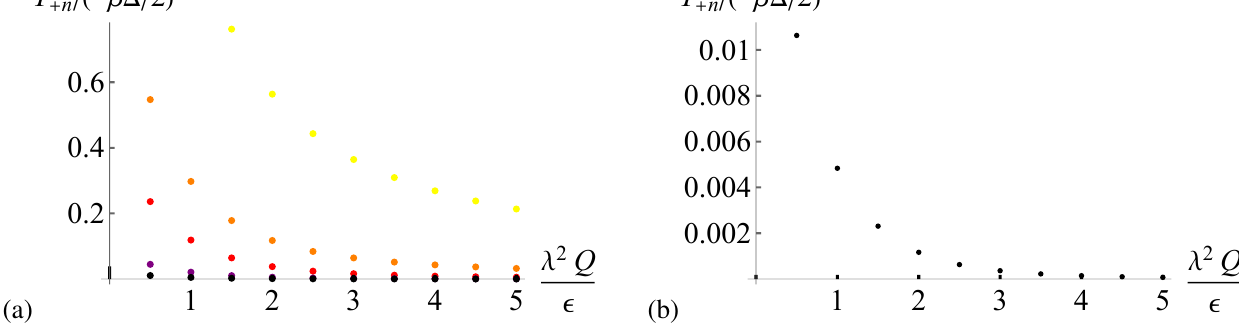
Figure 5: (a) Plots of T + , n / ( − β ∆ / 2) n in function of λ 2 Q in unit of ϵ , for ϵβ = 2 , and n = 1 (yellow dots), n = 2 (orange dots), n = 3 (red dots), n = 4 (purple dots), n = 5 (black dots). (b) Zoom in of the plot of T + , 5 / ( − β ∆ / 2) 5